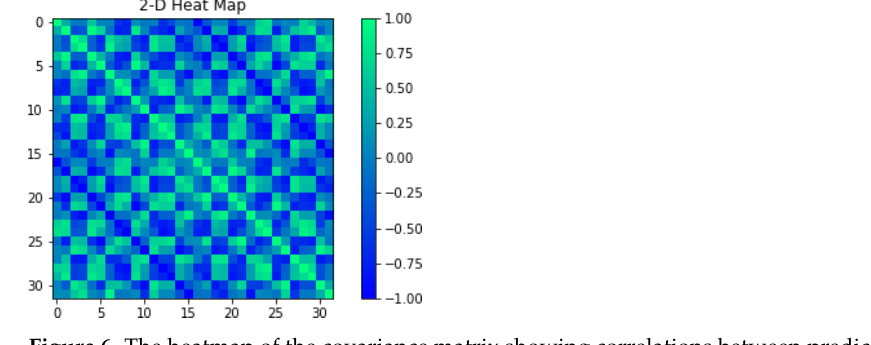
Figure 6. The heatmap of the covariance matrix showing correlations between predictors.